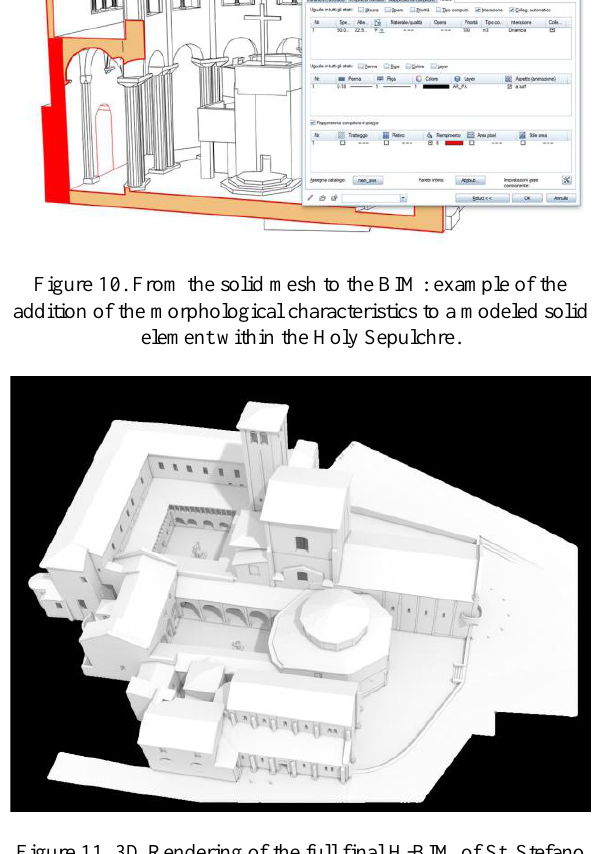
Figure 11. 3D Rendering of the full final H-BIM of St. Stefano Basilica (LOD